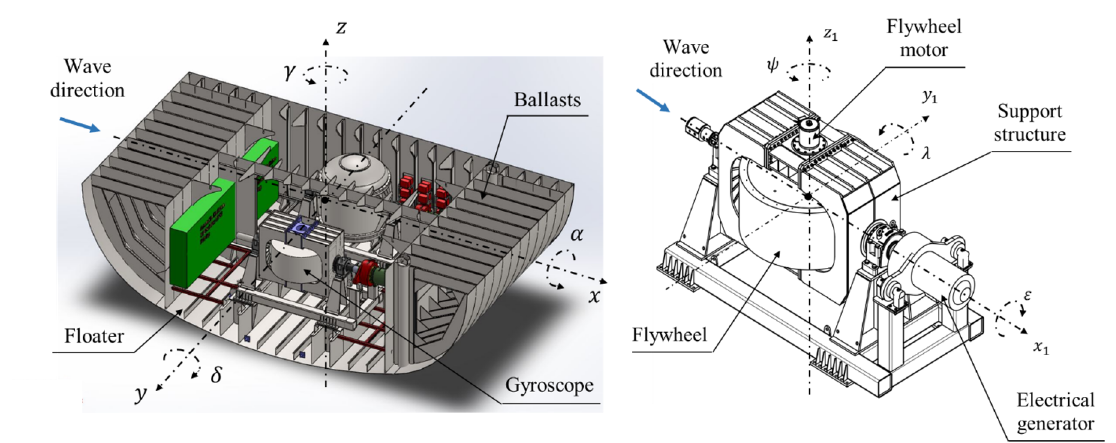
Figure 2. ISWEC full-scale configuration and internal components ( left ); ISWEC gyroscope ( right